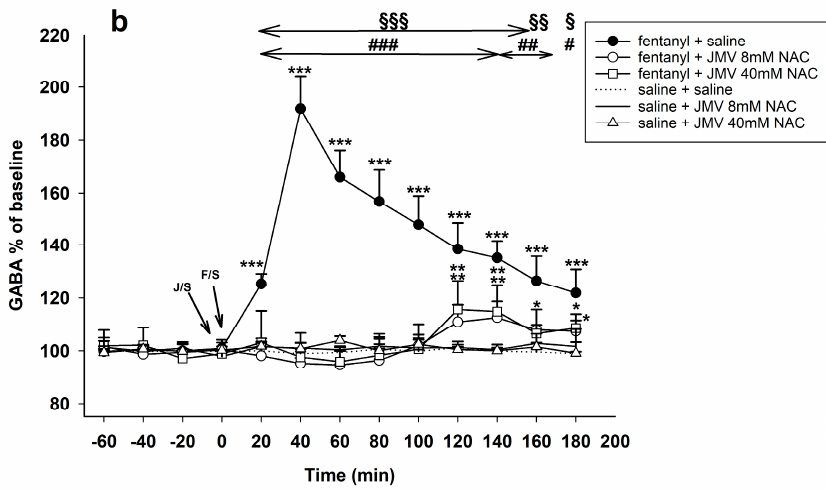
Figure 6. Effects of ghrelin receptor antagonist JMV2959 administered following four 20 min baselines into the VTA and into the NAC 5 min before fentanyl/saline on the accumbens GABA levels (means ± SEM). The effects are illustrated as follows: ( a ) Ringer’s solution/VTA + fentanyl (filled circle), 2 µg JMV2959/VTA + fentanyl (open circle), 10 µg JMV2959/VTA + fentanyl (open square), 2 µg JMV2959/VTA + saline (continuous line), 10 µg JMV2959/VTA + saline (open triangle), and Ringer’s solution + saline (dotting); and ( b ) saline + fentanyl (filled circle), JMV2959 lower dose 8 mM/15 min/NAC + fentanyl (open circle), JMV2959 higher dose 40 mM/15 min/NAC + fentanyl (open square), JMV2959 lower dose 8 mM/15 min/NAC + saline (continuous line), JMV2959 higher dose 40 mM/15 min/NAC + saline (open triangle), and Ringer’s solution + saline (dotting). Differences between treatments and the control group (Ringer’s/VTA + saline or saline/saline) are expressed as *** p < 0.001, ** p < 0.01, * p < 0.05. Differences between fentanyl and fentanyl in combinations with the higher JMV2959 dose (10 µg/VTA or 40 mM/15 min/NAC, respectively) are expressed as ### p < 0.001, ## p < 0.01, # p < 0.05. Differences between fentanyl and fentanyl in combinations with the lower JMV2959 dose (2 µg/VTA or 8 mM/15 min/NAC, respectively) are expressed as §§§ p < 0.001, §§ p < 0.01, § p < 0.05. The horizontal arrows show intervals with appropriate significant changes ( §§§ or ## or ### ); the oblique arrows show the time of administration of J/S = JMV2959/saline or J/R = JMV2959/Ringer´s solution and F/S = fentanyl/saline. JMV2959 pre-treatment into the VTA 5 min before fentanyl using both doses significantly and comparably reduced the opioid-induced GABA increase to the baseline levels. During the two last hours of microdialysis the accumbens GABA levels were oscillating around border significant increase in comparison to baseline concentrations (around 110% maximum). For the lower JMV2959 dose: JMV2959 2 µg/VTA + fentanyl 30 µg/kg vs. Ringer’s solution/VTA + fentanyl 30 µg/kg: effect of group F1,10 = 63.9, p < 0.001; effect of time F9,90 = 18.3, p < 0.01; time × group interaction F9,90 = 10.1, p < 0.001. For the higher dose: JMV2959 10 µg/VTA + fentanyl 30 µg/kg vs. Ringer’s solution/VTA + fentanyl 30 µg/kg: effect of group F1,10 = 101.5, p < 0.001; effect of time F9,90 = 20.0, p < 0.01; time × group interaction F9,90 = 16.1, p < 0.001. Both doses of JMV2959/VTA with fentanyl 30 µg/kg showed very low but significant GABA increase only at the end of the third hour after fentanyl administration: JMV2959 2 µg/VTA + fentanyl 30 µg/kg vs. Ringer’s solution/VTA + saline: effect of group n.s.; effect of time F9,90 = 3.4, p < 0.01; time × group interaction F9,90 = 3.0, p < 0.01; maximum effect 109% of baseline; JMV2959 10 µg/VTA + fentanyl 30 µg/kg vs. Ringer’s solution/VTA + saline: effect of group n.s.; effect of time F9,90 = 3.4, p < 0.01; time × group interaction F9,90 = 2.8, p < 0.01; maximum effect 109% of baseline. A single dose of JMV2959 2 µg/VTA similarly to saline had no effect on accumbens GABA. A single 10 µg/VTA dose of JMV2959 induced slight but significant increase of accumbens GABA: JMV2959 10 µg/VTA + saline vs. Ringer’s solution/VTA + saline: effect of group n.s.; effect of time n.s.; time × group interaction F9,90 = 2.3, p < 0.05; with maximum effect of 104% of baseline.